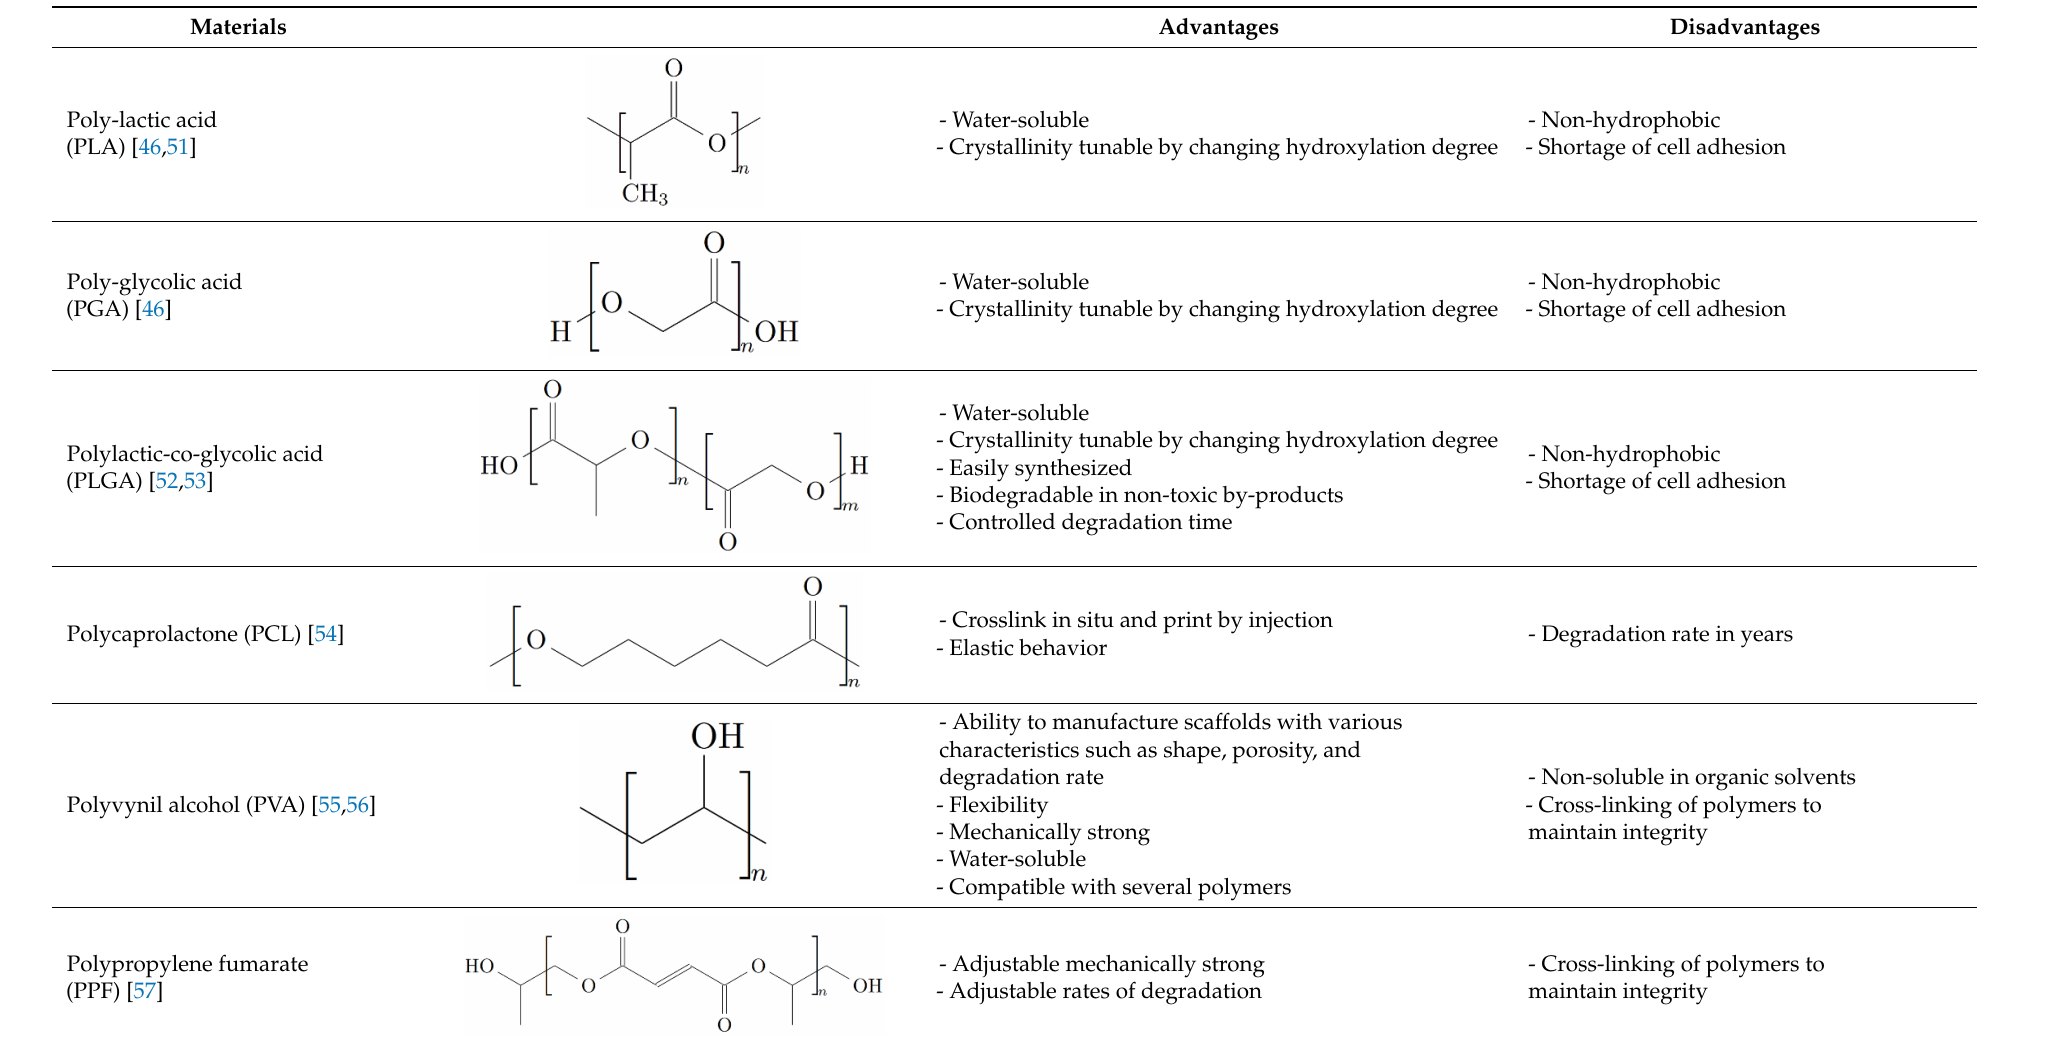
Table 1. Materials, advantages, disadvantages of scaffolds for implant